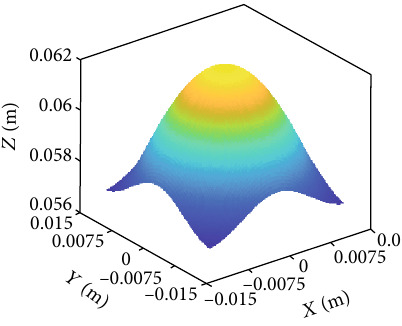
Figure 13: Workspace of the parallel